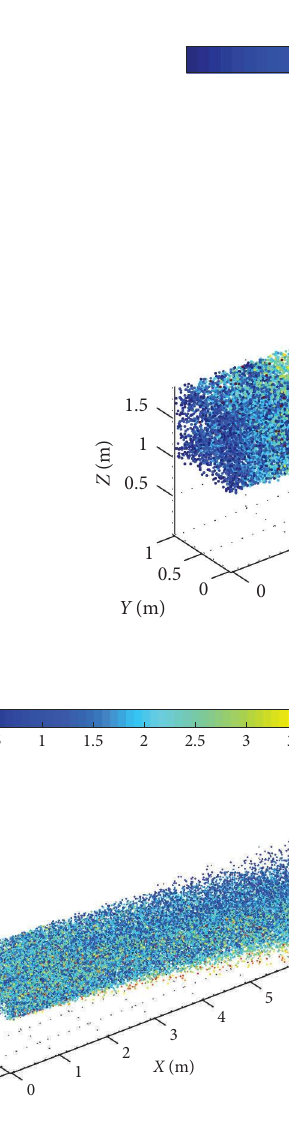
Figure 13: Diameter distribution of particles.